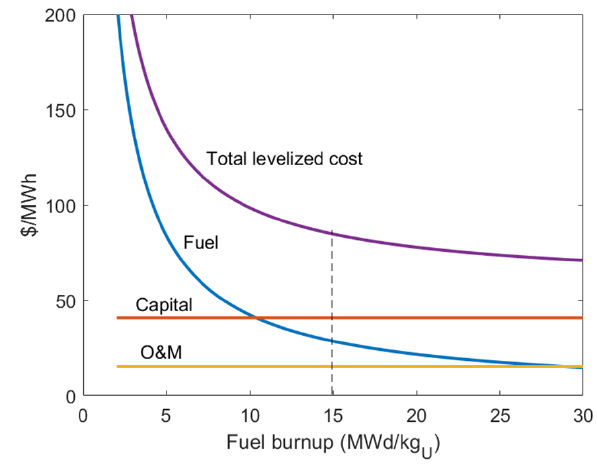
Figure 10. NB levelized electricity costs vs. fuel burnup.